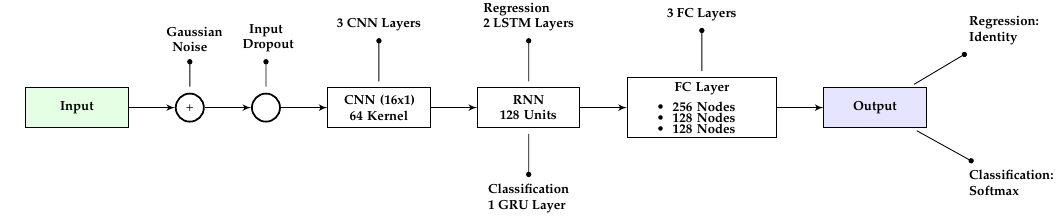
Figure 2. Overview of the proposed network